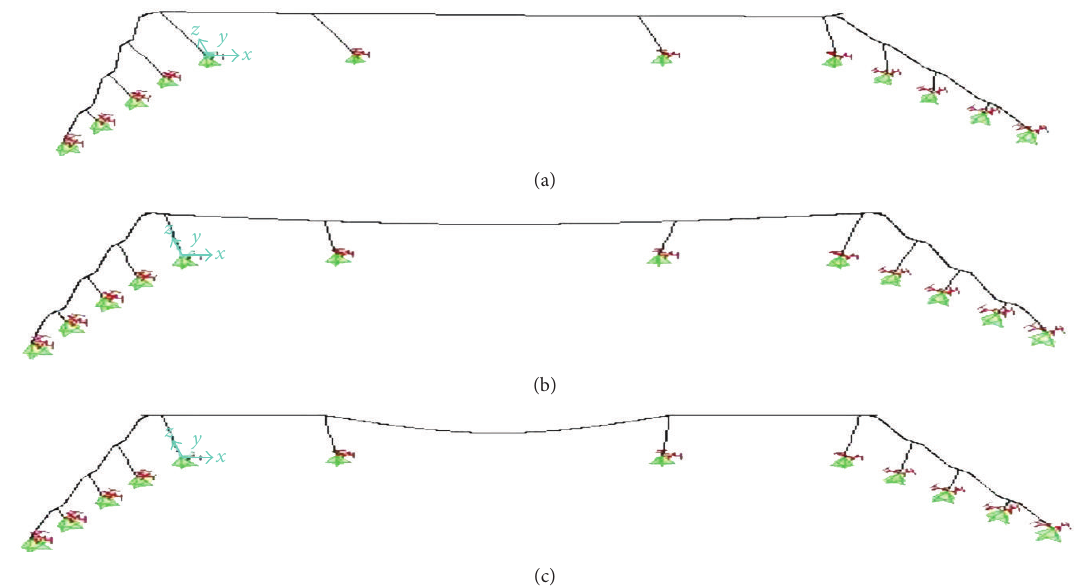
Figure 18: Modes of vibration: (a) 1st longitudinal; (b) 2nd tranversal; (c) 3rd vertical, central